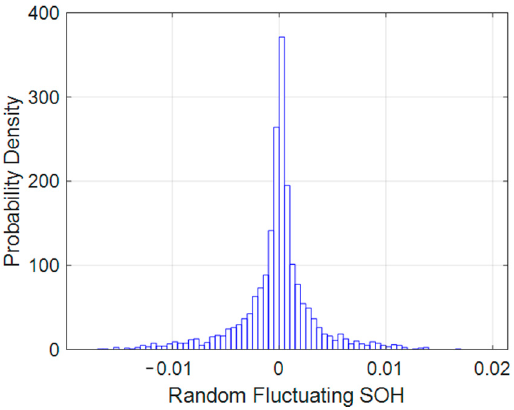
Figure 7. State of health probability density diagram with random